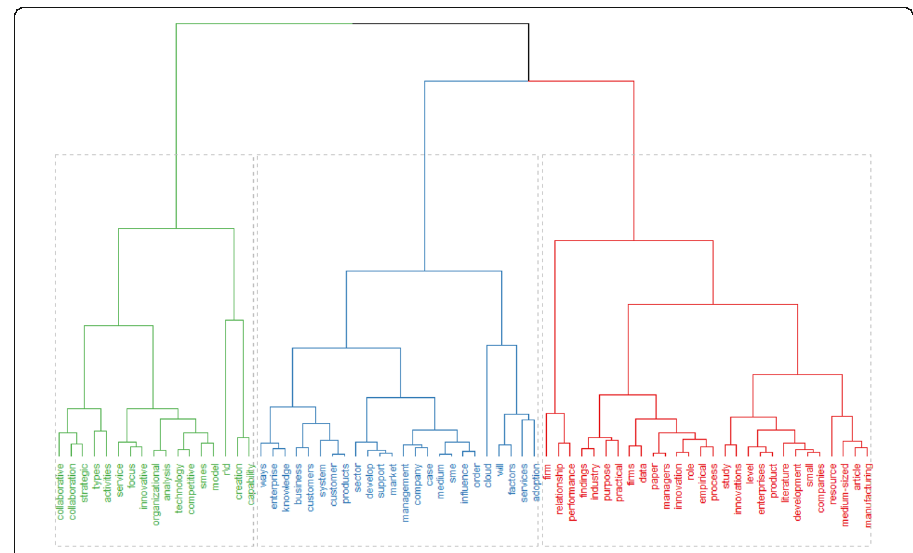
Fig. 9 Formulation of clusters according to the frequency of